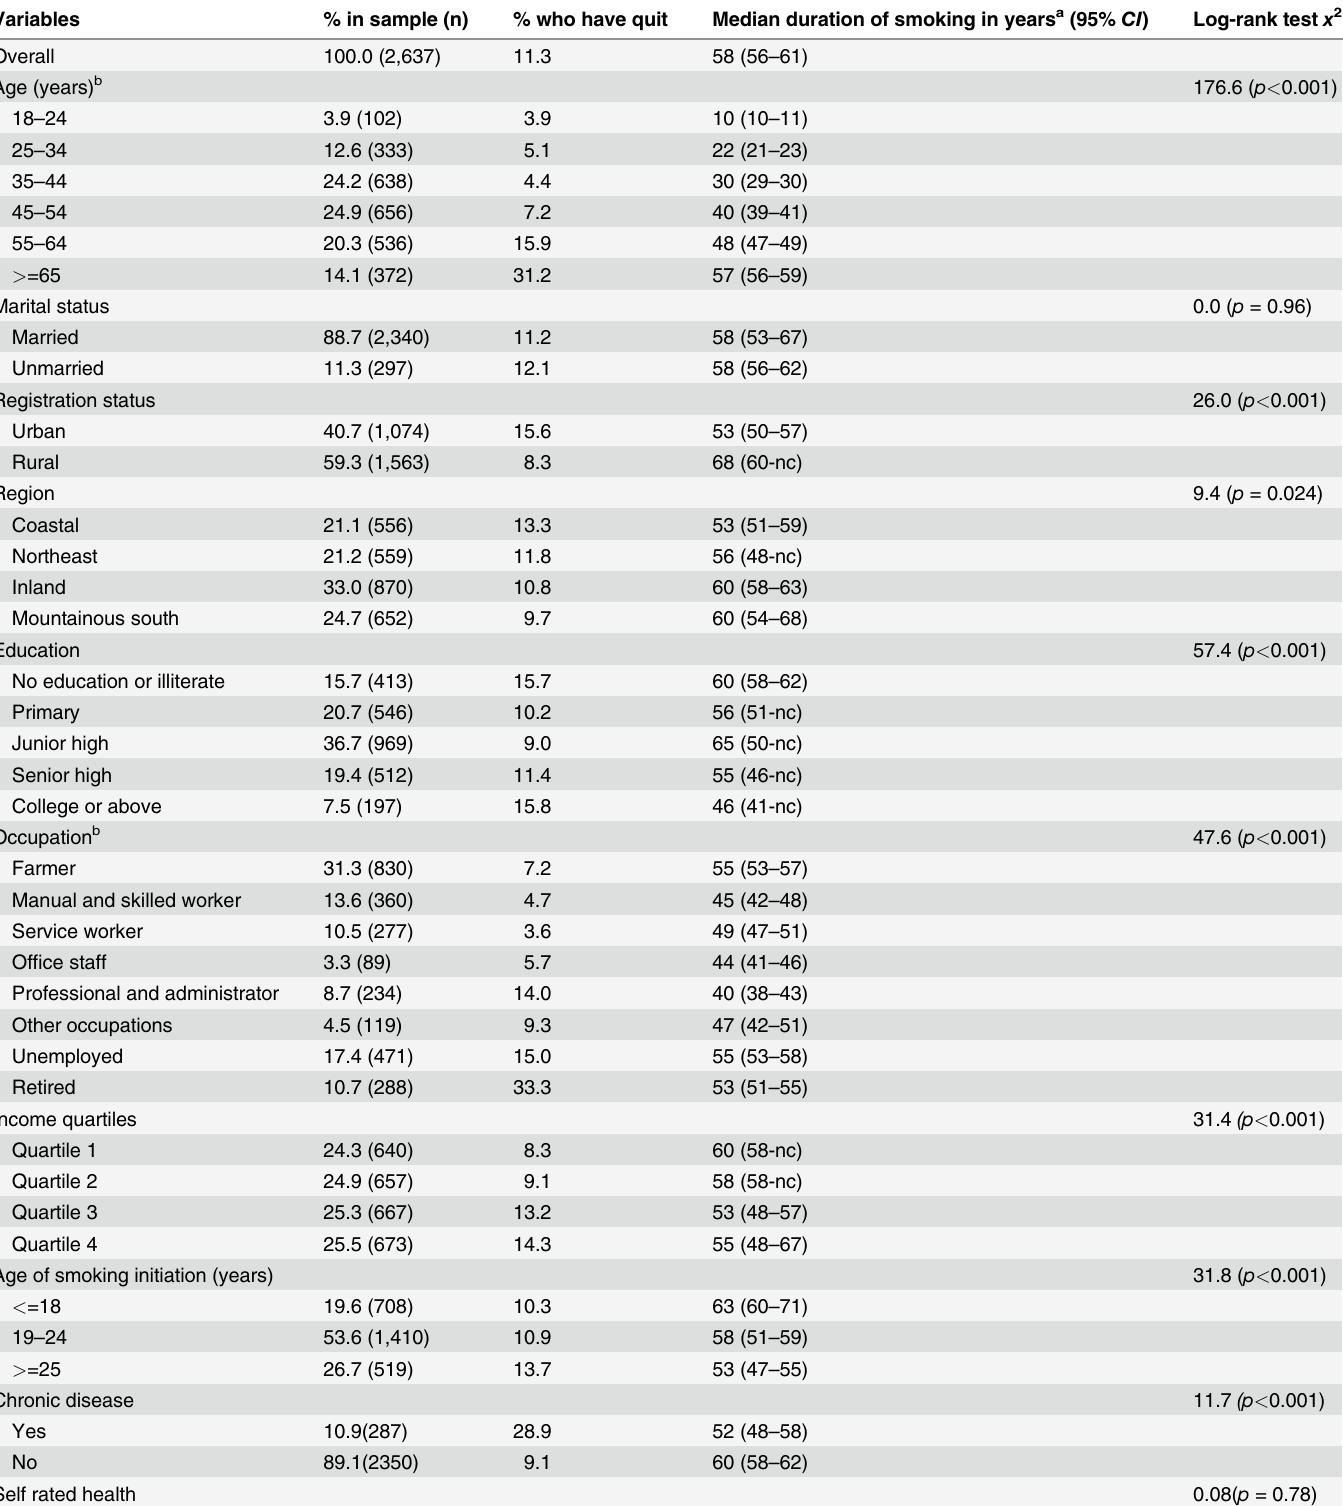
Table 1. Sample Characteristics and Distribution of Smoking Duration among Male Ever Smokers Aged 18+, CHNS, 2006 (N =